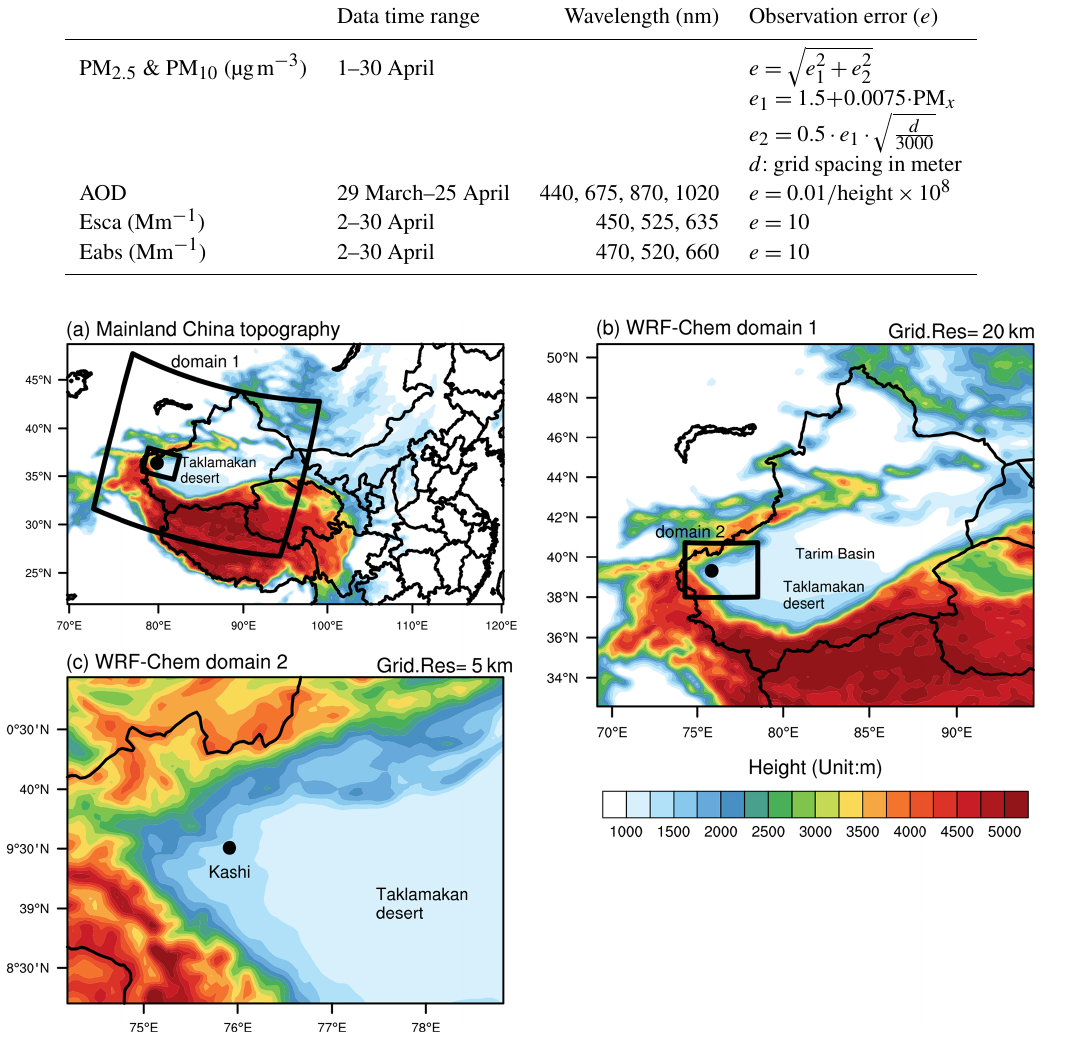
Figure 4. Topography in China (a) and the model domains with the grid resolution of 20km (b) and 5km (c) in WRF-Chem.